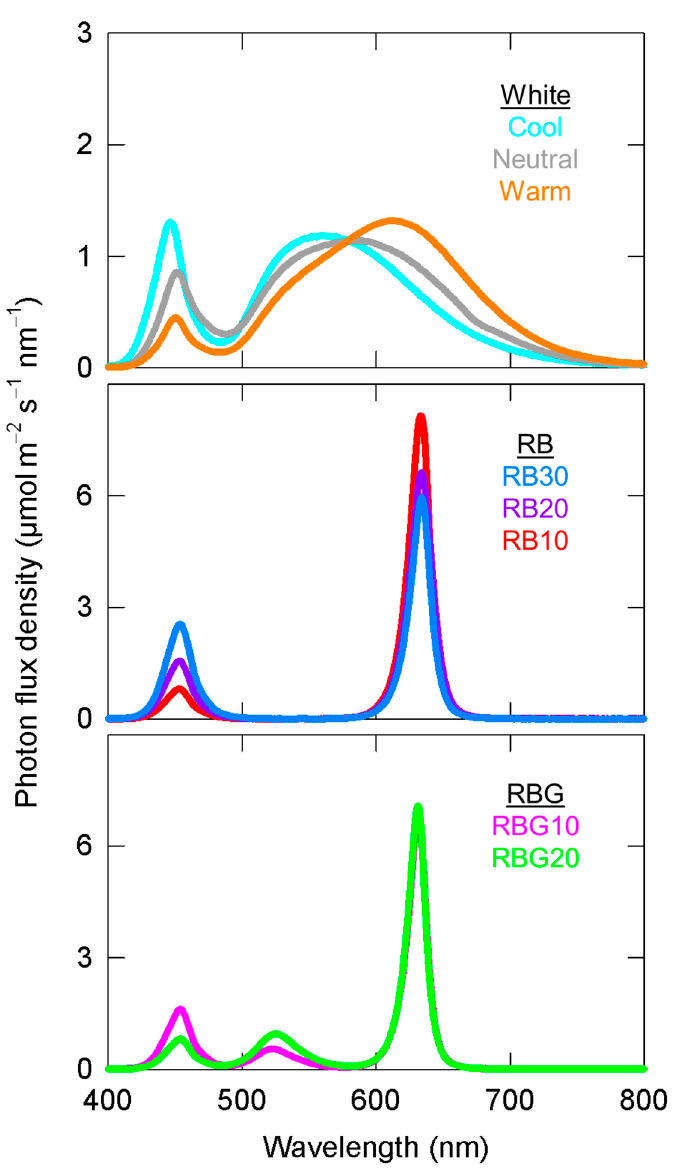
Figure 1. Representative spectral output of each of the eight treatments at a PPFD of 200 µmol m − 2 s − 1 . (Top) the three white LEDs, (middle) the three RB (red/blue) combinations, (bottom) the two RBG (red/blue/green) treatments.